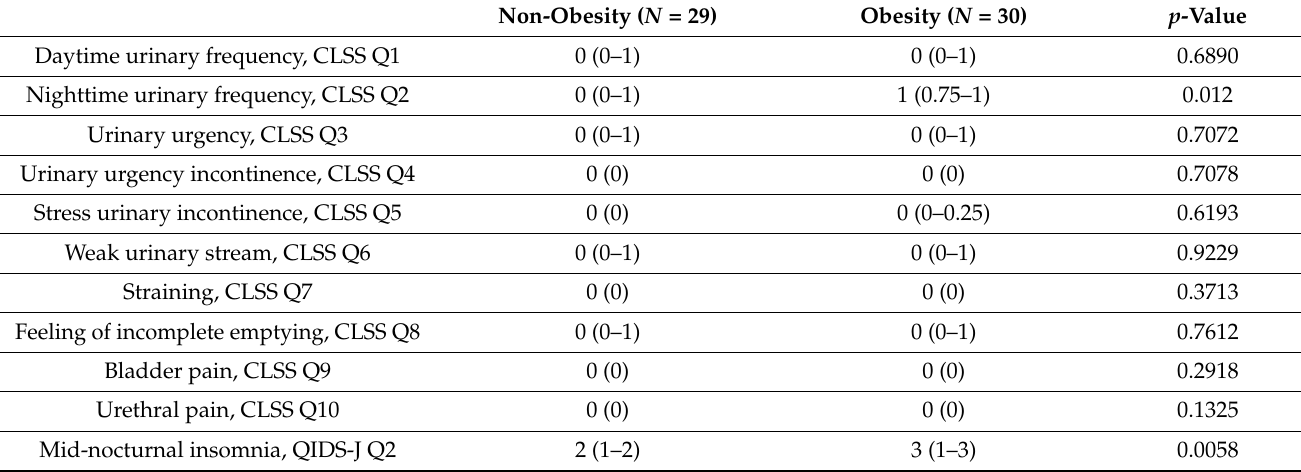
Table 2. Self-reported urinary tract symptoms of participants grouped by obese